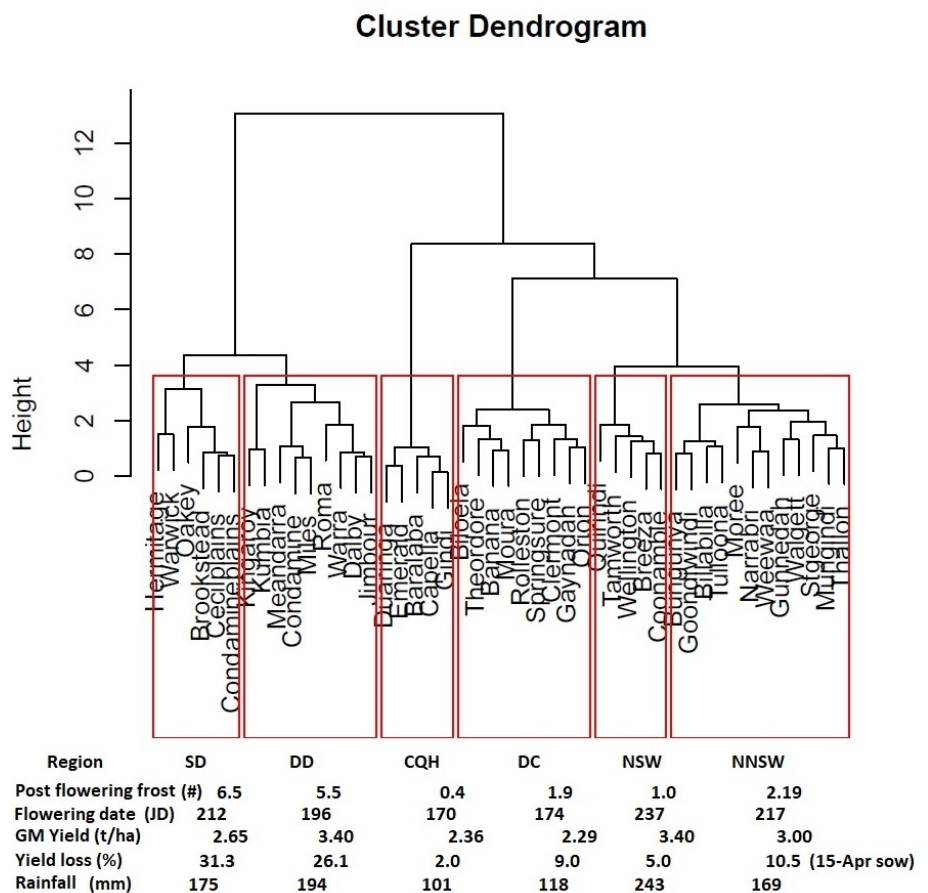
Figure 2. Sub-regions developed using the mean number of post-flowering frost events, flowering date (Julian date), gross margin yield, yield loss for 15-April sowing and in season rainfall. The sub-regions are CQH = Central Queensland Highlands, DC = Dawson Callide, NNSW-WD = Northern New South Wales and Western Downs (Queensland), NSW = New South Wales, SD = Southern Downs, DD = Darling Downs. The frost indices were derived using 15-April sowing.